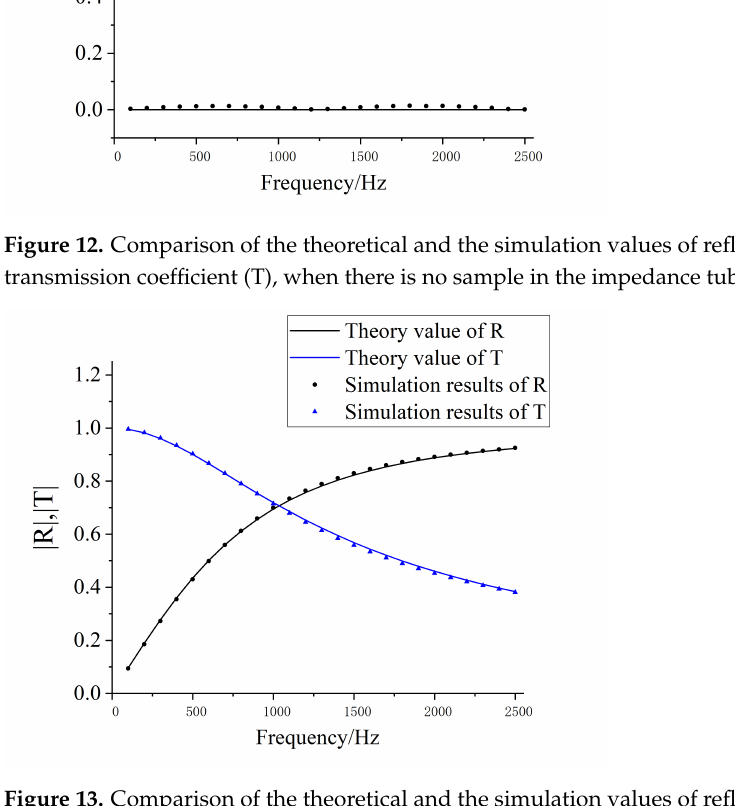
Figure 13. Comparison of the theoretical and the simulation values of reflection coefficient (R) and transmission coefficient (T), when there is a steel sample in the impedance